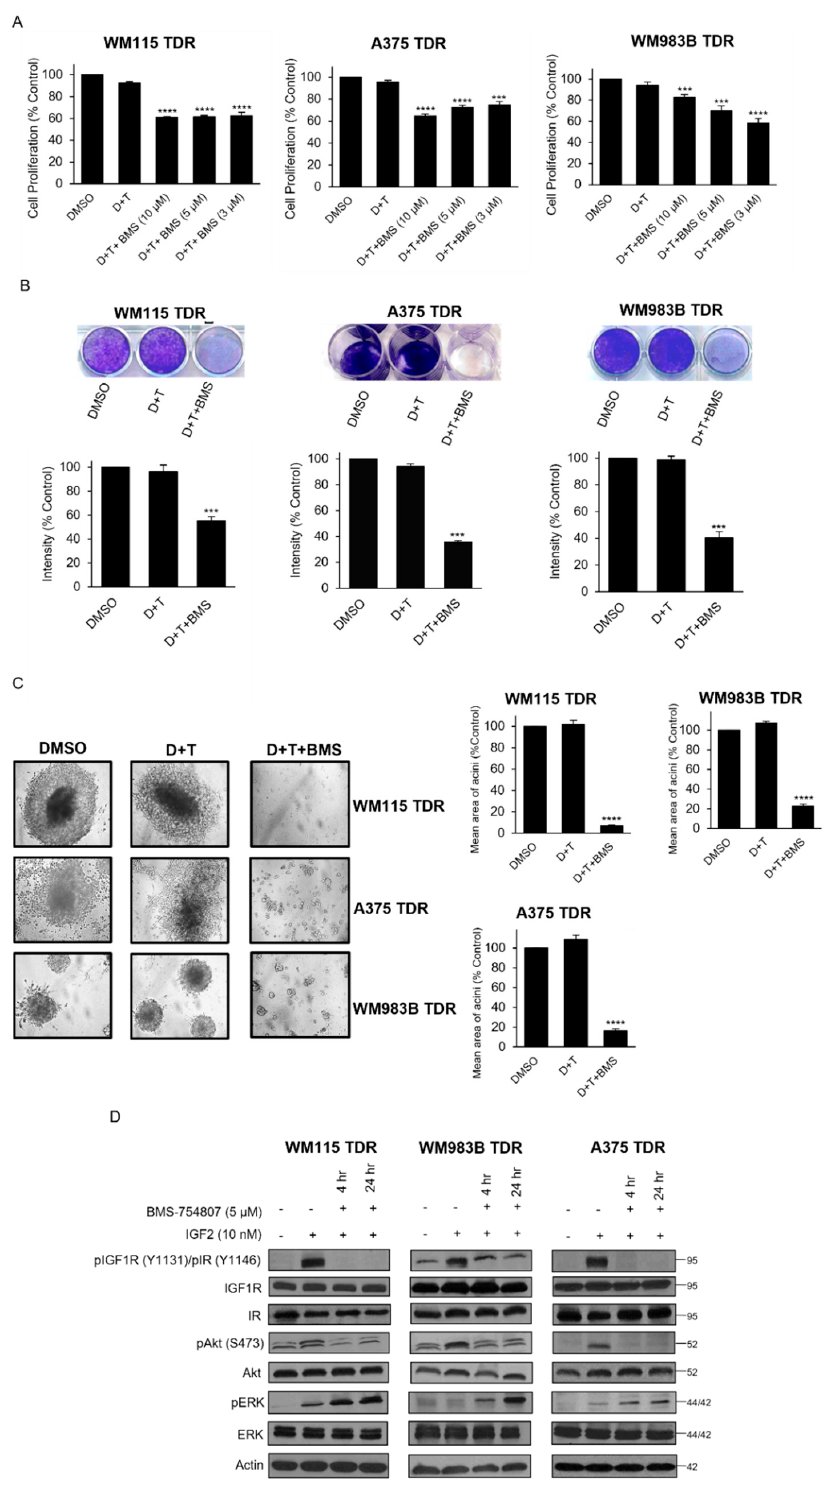
Figure 4. BMS ‐ 754807 in combination with dabrafenib and trametinib inhibits cell proliferation and inhibits intracellular Akt ( A ) TDR cells (WM115, WM983B, and A375) plated for 24 h and treated with DMSO, dabrafenib (D), and trametinib (T) (WM115: D: 800 nM, T: 200 nM; WM983B: D: 2.4 µ M, T: 500 nM; A375: D: 250 nM, T: 12.5 nM) treated alone or in combination with BMS ‐ 754807 (3, 5, and 10 μ M) and treated with MTT. The intensities are represented as mean. Error bars: SEM *** p < 0.001; **** p < 0.0001 by two ‐ tailed Student’s t ‐ test compared to DMSO group. ( B ) TDR cells were